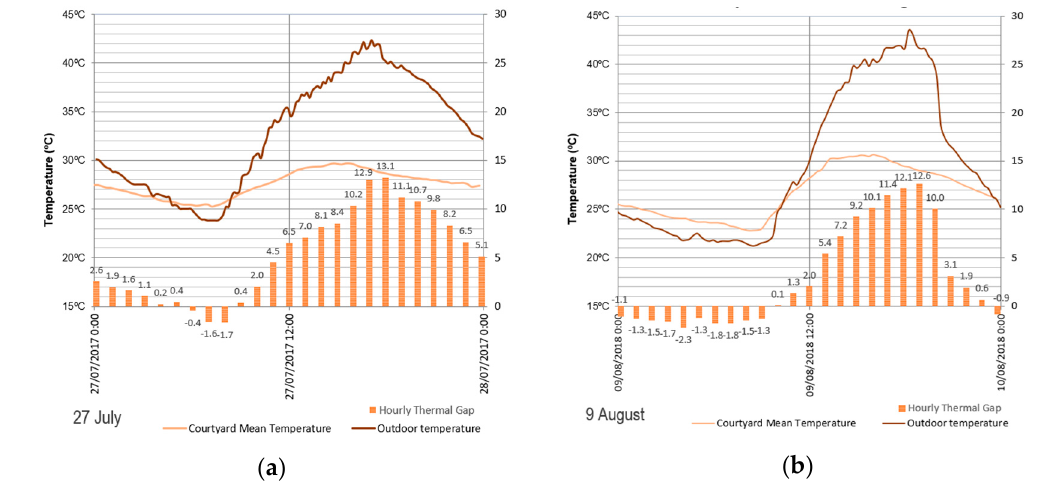
Figure 3. Outdoor and Courtyard temperature and Thermal Gap with shading device. ( a ) Courtyard A in Córdoba; ( b ) Courtyard B in